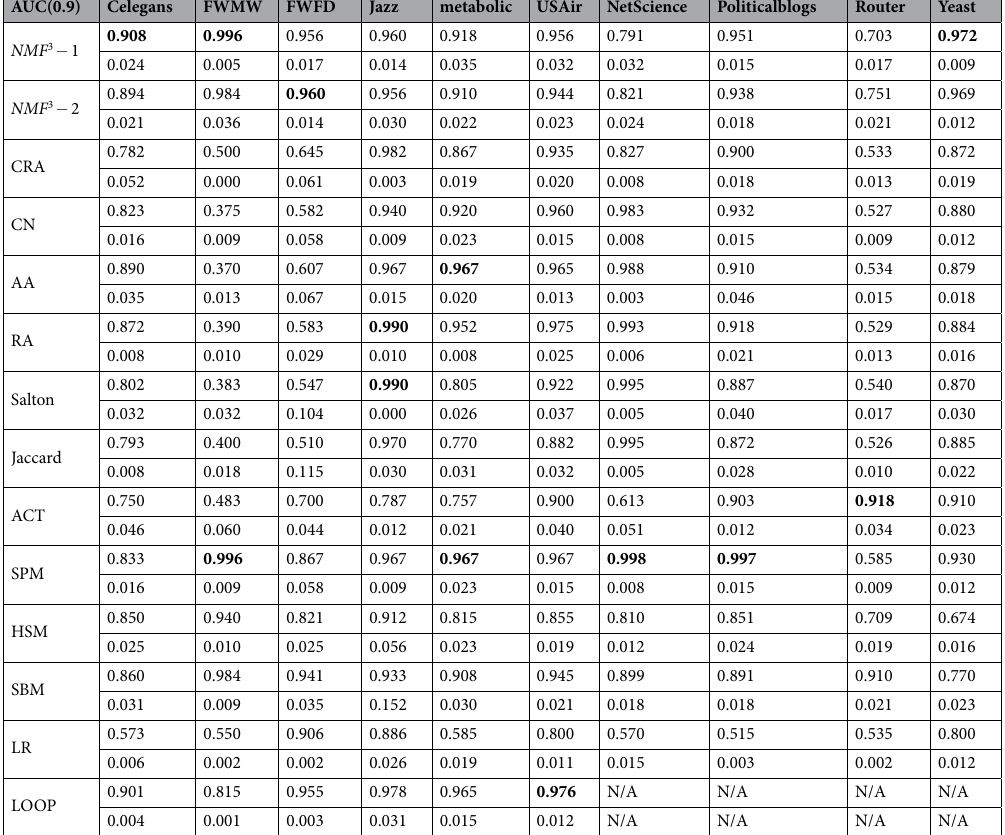
Table 3. Link prediction accuracy measured by AUC on the 10 real networks. We compared our methods ( NMF 3 − 1, NMF 3 − 2) with other methods on the 10 network data sets and the AUC are returned with an average run of over 100 times. For each data set, the presented links are partitioned into training set (90%) and test set (10%).